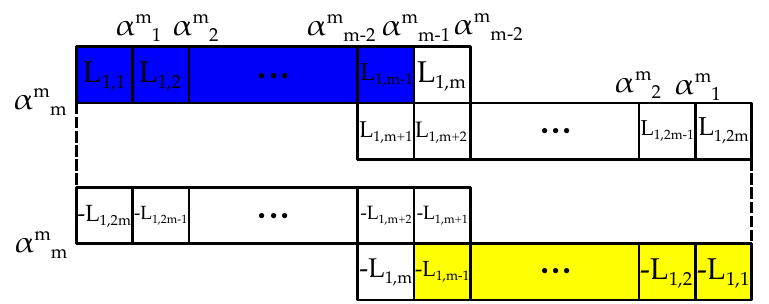
Figure 8. We show the subdiagram of the box graph for which the consistent decoration spec- i(cid:12)es the (cid:13)avor-equivalence classes of Sp( N ) with m = N f fundmental hypermultiplets. We have decorated all of the weights whose decoration is (cid:12)xed by (3.23) and the (cid:13)ow rules (2.20).